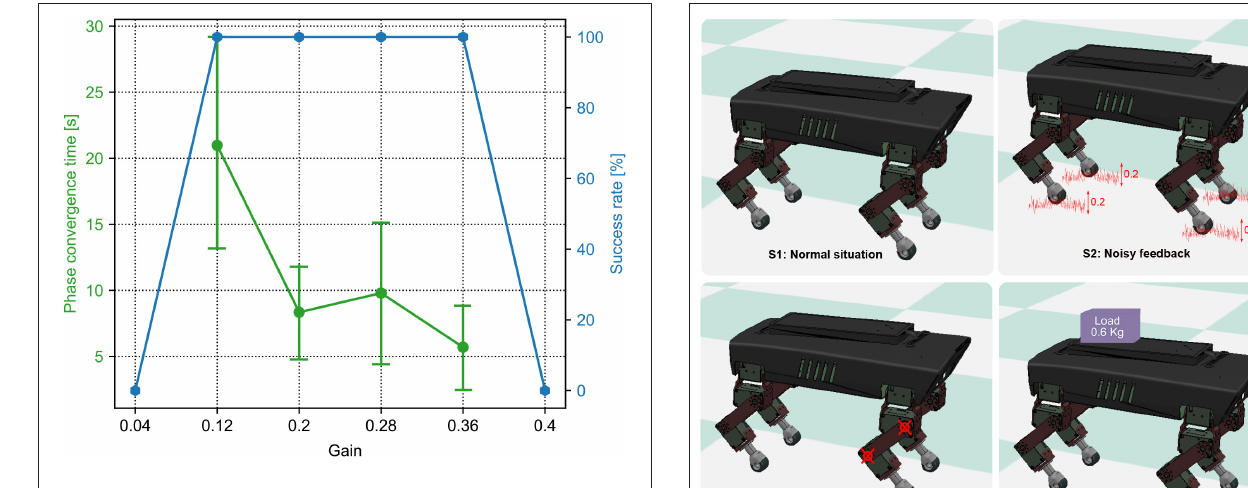
FIGURE 4 | The phase convergence time and success rate of the PM trials with different sensory feedback gains ( γ in Equation 6). The green points and bars show the average and variance of the phase convergence time, respectively. The blue points represent the success rate. When the gain is 0.36, the success rate is 100% and has the fastest phase convergence.